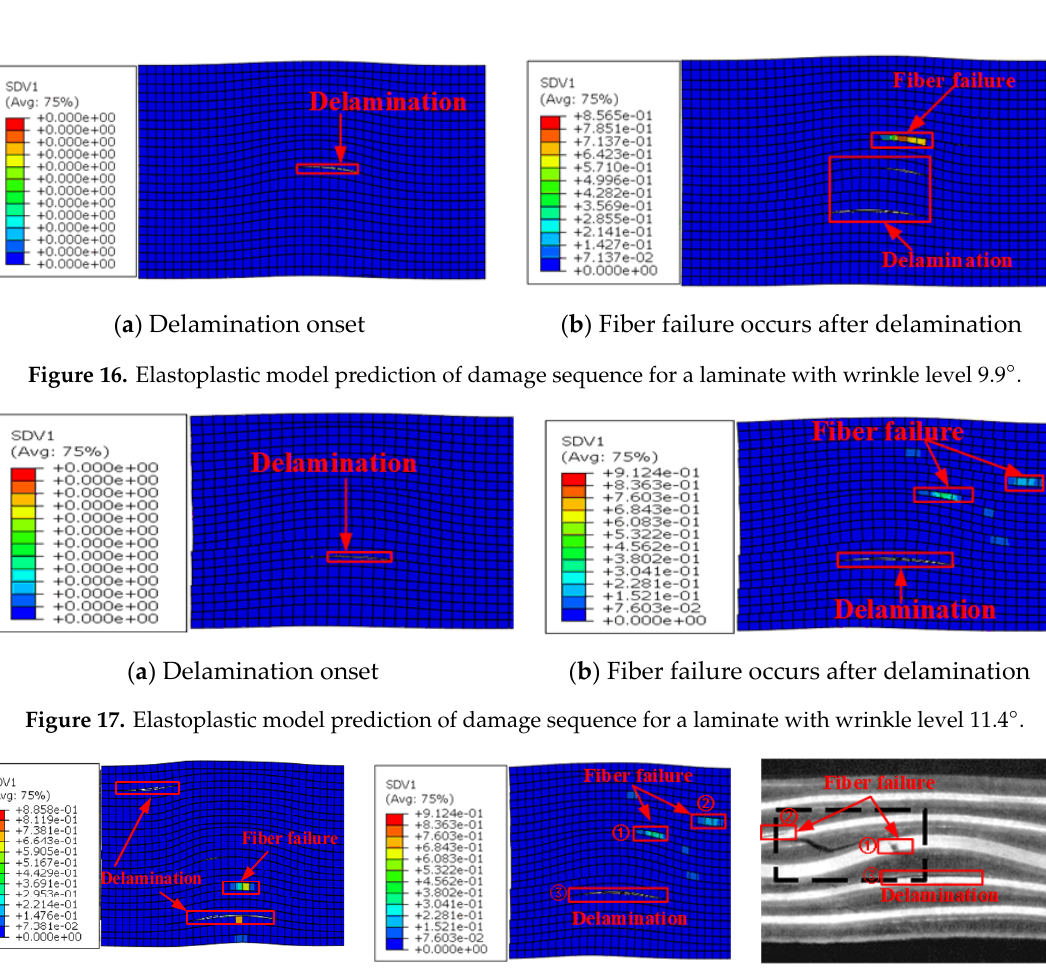
( c ) Experimental images Figure 15. Damage evolution in a specimen with wrinkle level 5.6°. ( a ) Predicted by the elastic model, ( b ) predicted by the elastoplastic model, and ( c ) from high-speed camera images of the damage sequence in [10]. The elastoplastic damage prediction results for laminates of wrinkle levels 11.4° and 9.9° are shown in Figures 16 and 17, respectively. The same damage sequence was observed in these two cases. Inter-ply delamination initiated earlier than fiber failure for the wrinkle severity levels 11.4° and 9.9°, in contrast to the case of wrinkle level 5.6°. This is in accordance with the results of